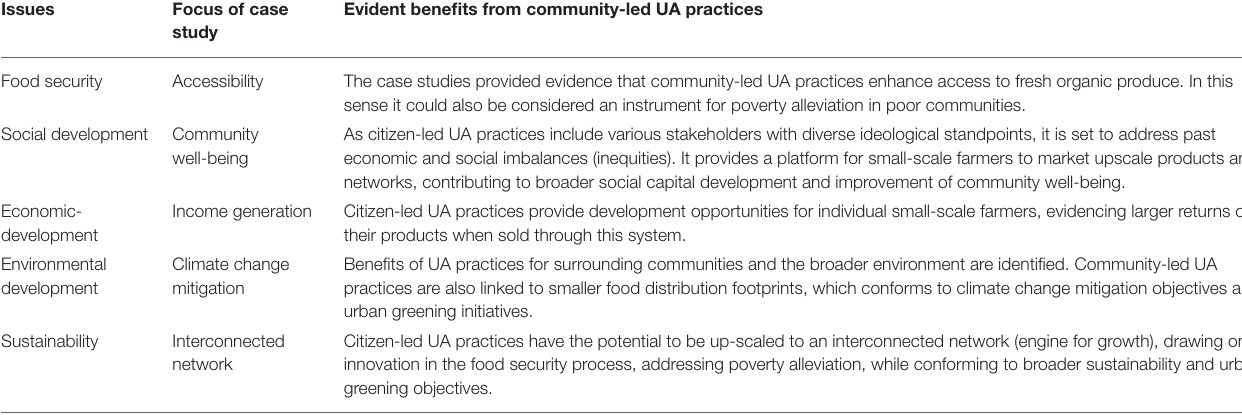
TABLE 2 | Broader spin-offs relating to the UA initiatives in Cape